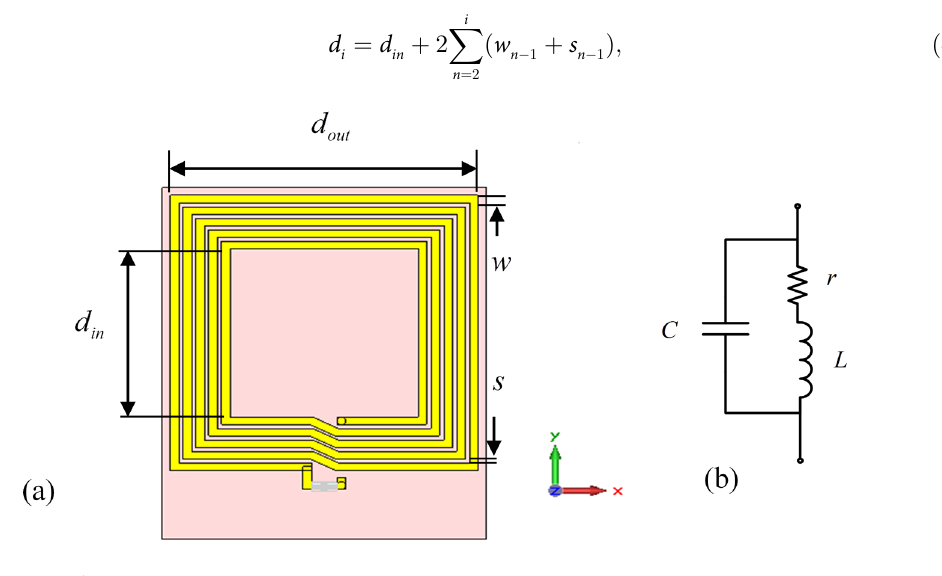
Fig 1. Planar square loop. (a) geometry (b) electrical